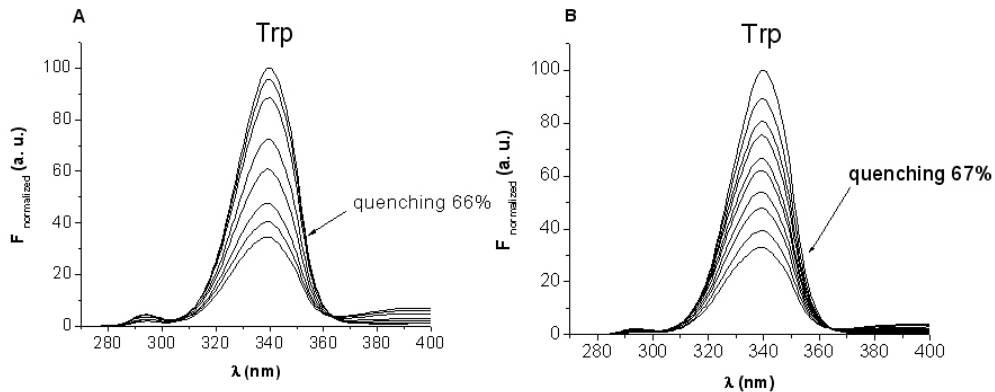
Figure 9. The effect of addition of (I) on the synchronous fluorescence spectrum at Δλ = 60 nm of A) HSA; B) BSA; T=298 K; pH=7.4;d/p=0-8.03.